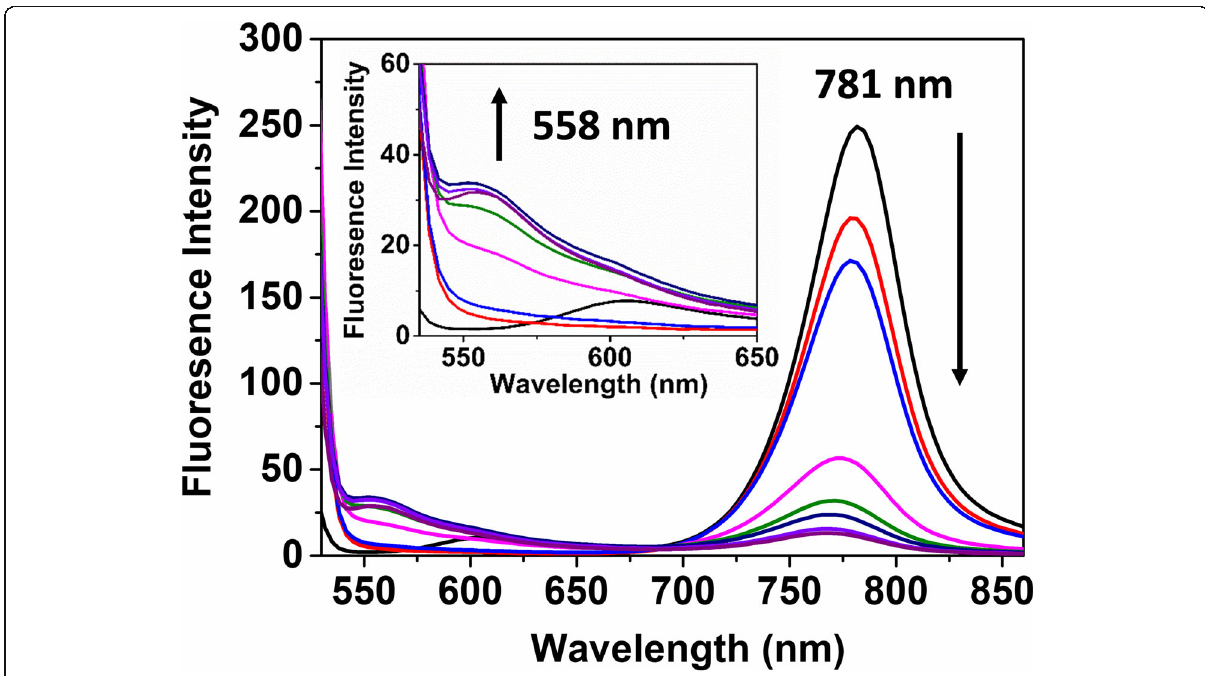
Fig. 2 Fluorescence spectrum of probe 1 (1.0 μ M) upon adding of Ag + (0, 0.05, 0.1, 0.5, 1.0, 2.0, 3.0, 4.0 μ M) in HEPES buffer solution (pH 8.0).